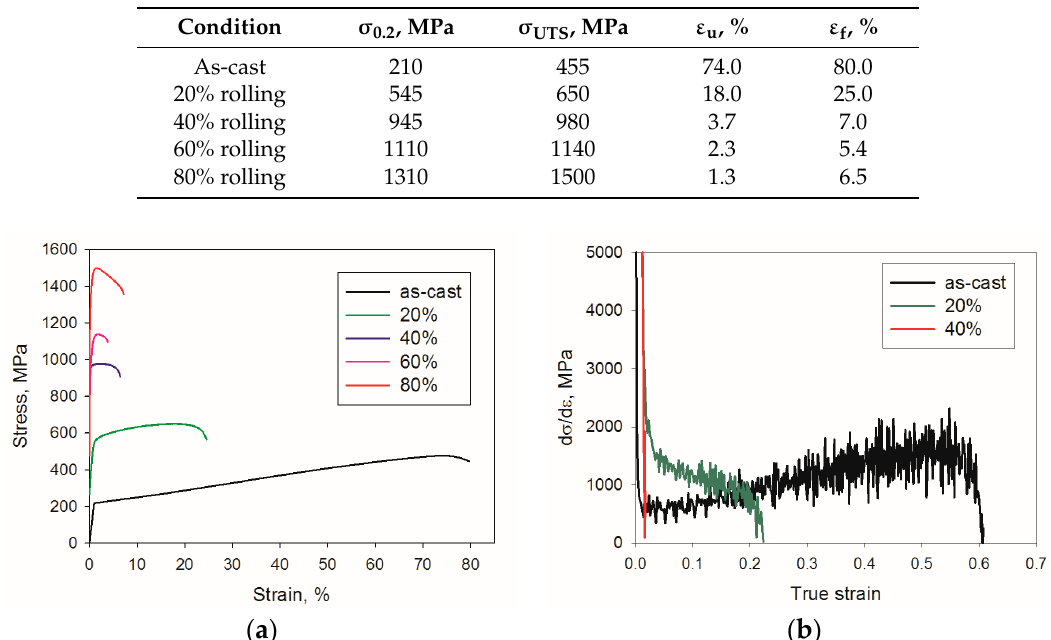
Table 2. Tensile properties of the Al-, C-containing CoCrFeNiMn-type alloy in different conditions. Condition